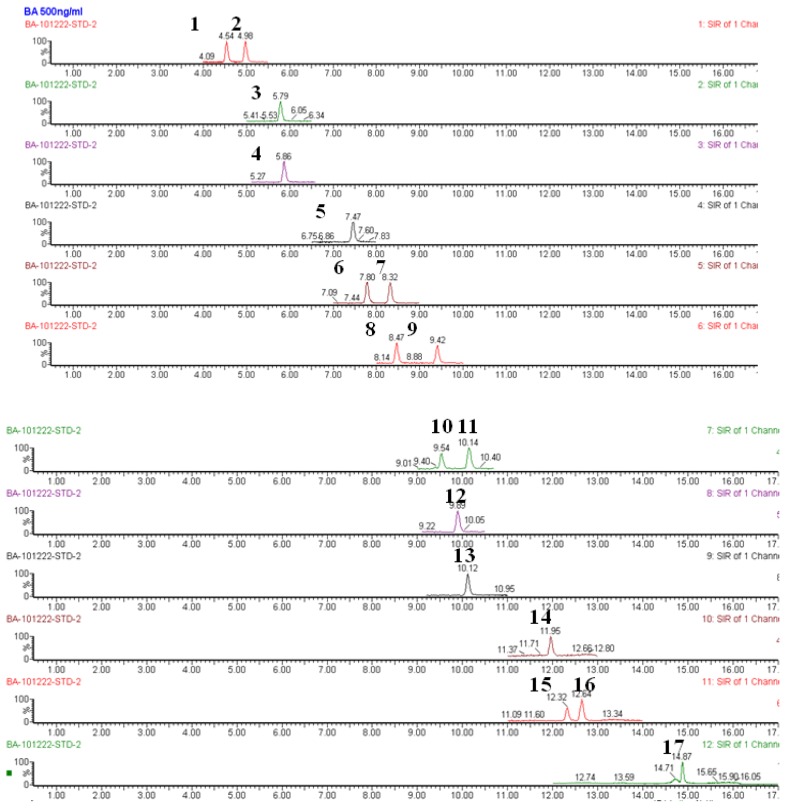
UPLC-MS-selected ion recording chromatogram of the blank serum spiked with a mixture of 500 ng/mL bile acid standards (1, TUDCA; 2, THDCA; 3, GUDCA; 4, TCA; 5, GCA; 6, TCDCA; 7, TDCA; 8, UDCA; 9, HDCA; 10, GCDCA; 11, GDCA; 12, CA; 13, TLCA; 14, GLCA; 15, CDCA; 16, DCA; 17, LCA).